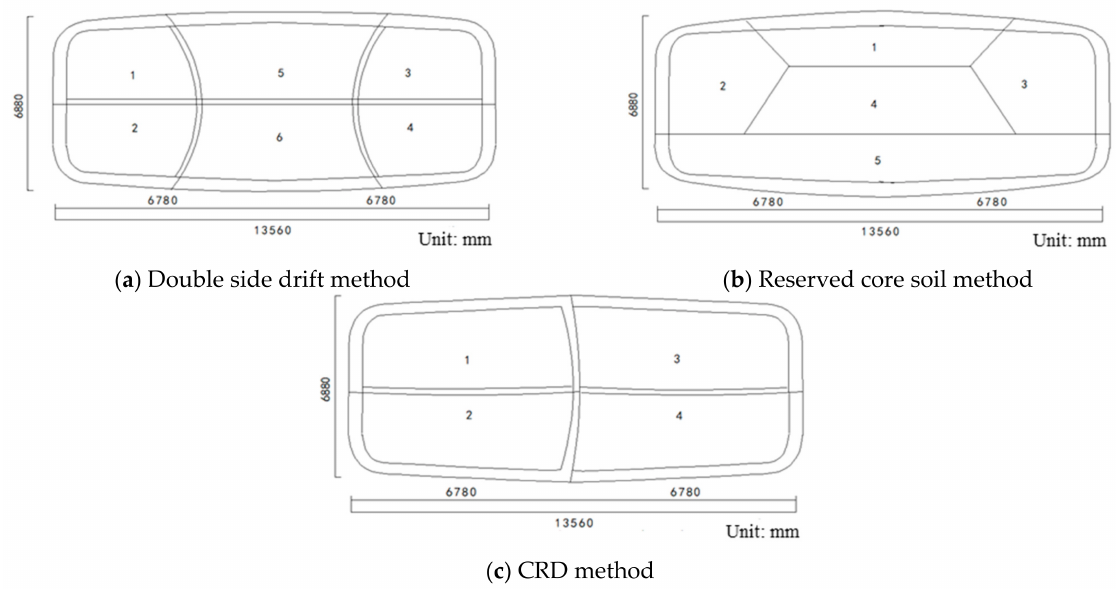
Figure 9. Schematic diagram of tunnel blasting excavation construction